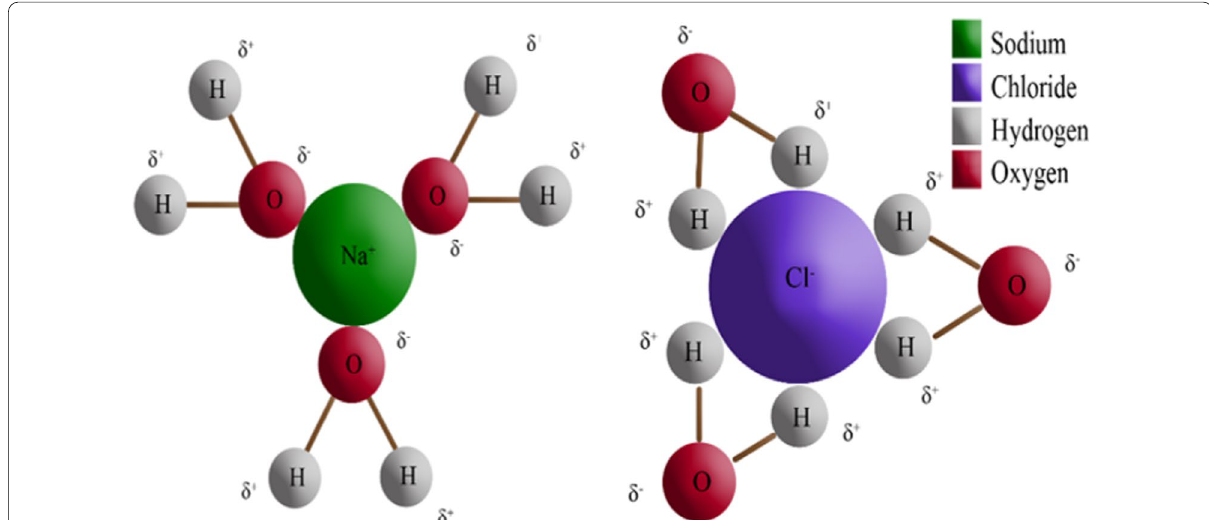
Fig. 1 A schematic diagram refers to the ions of sodium (Na + ) and chloride (Cl − ) while getting away from each other, in addition to the deformation of their hydration shells in water during the application of a magnetic field